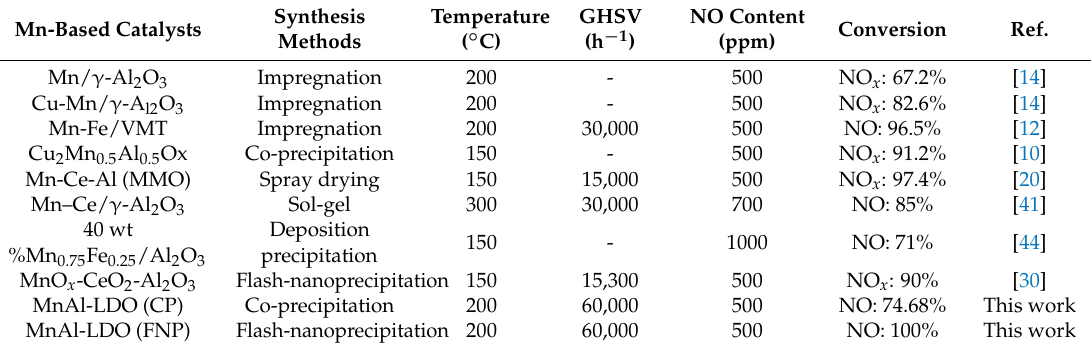
Table 3. Summary of catalytic activity for various Mn-based catalysts. In the table, GHSV means gas hourly space velocity, while MMO stands for mixed metal oxide.